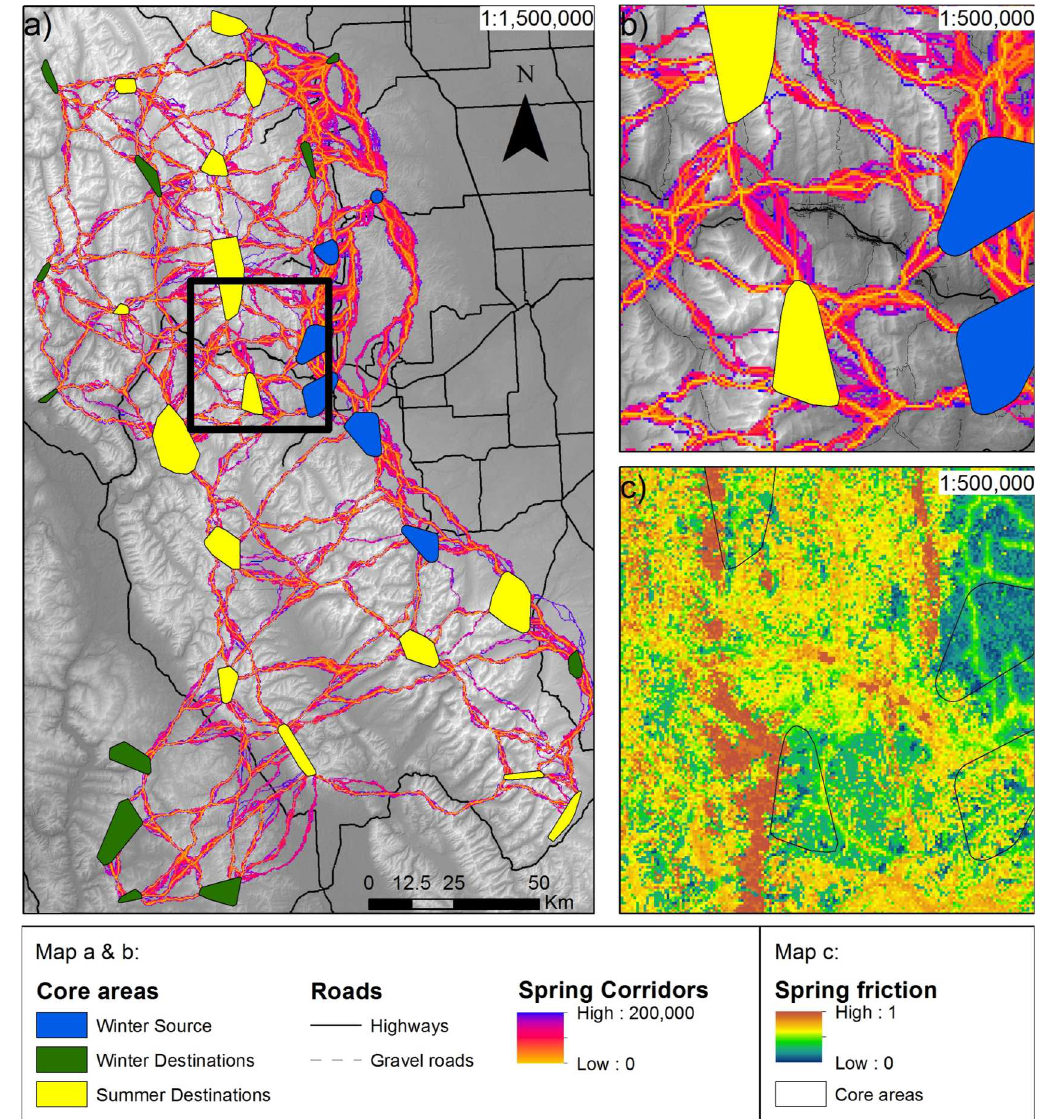
highway3; c) close up friction map produced from spring SSFs. Note that elk are predicted to move parallelor perpendicular to highway3 (map b), in contrast to what is depicted in S5 Fig, where elk are predicted to move along highway3 at the bottom of the valley, which would be the movement if there were no